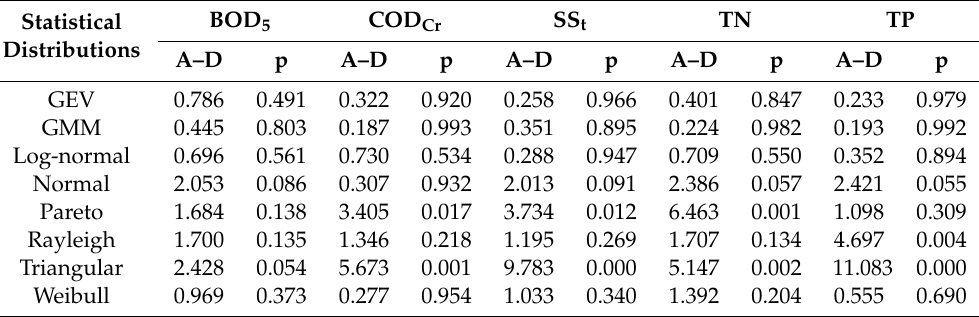
Table 2. The results of theoretical distributions fitting to empirical random variables